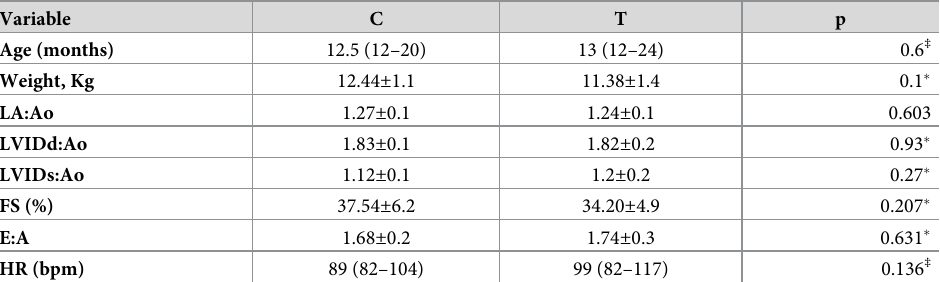
Table 1. Baseline physical characteristics and cardiac measures of the dogs.